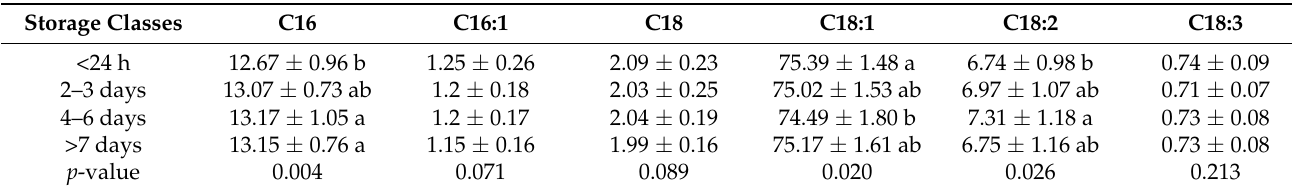
Table 2. Fatty acid composition of oils produced by olives after different olive storage duration. Values are mean ± standard deviation. Values followed by different letters in the same column (a, b) were significantly different according to Tukey’s test ( p < 0.05).